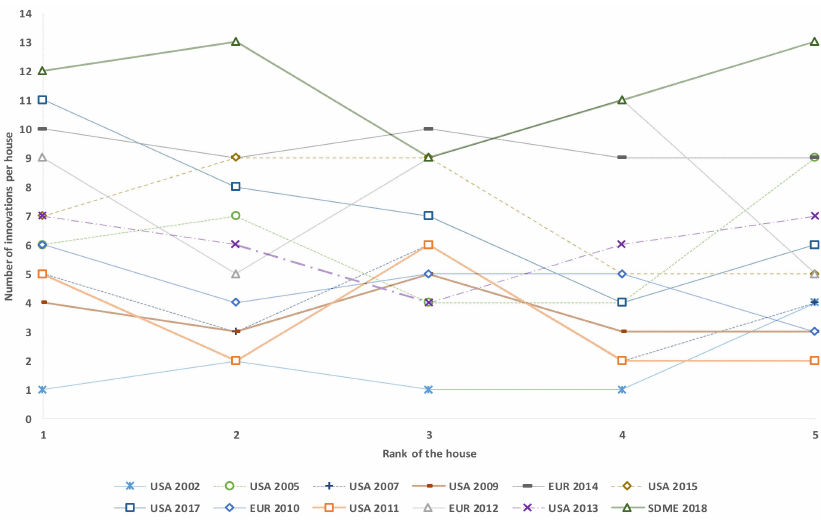
Figure 17. Innovations versus the ranking of the houses in the